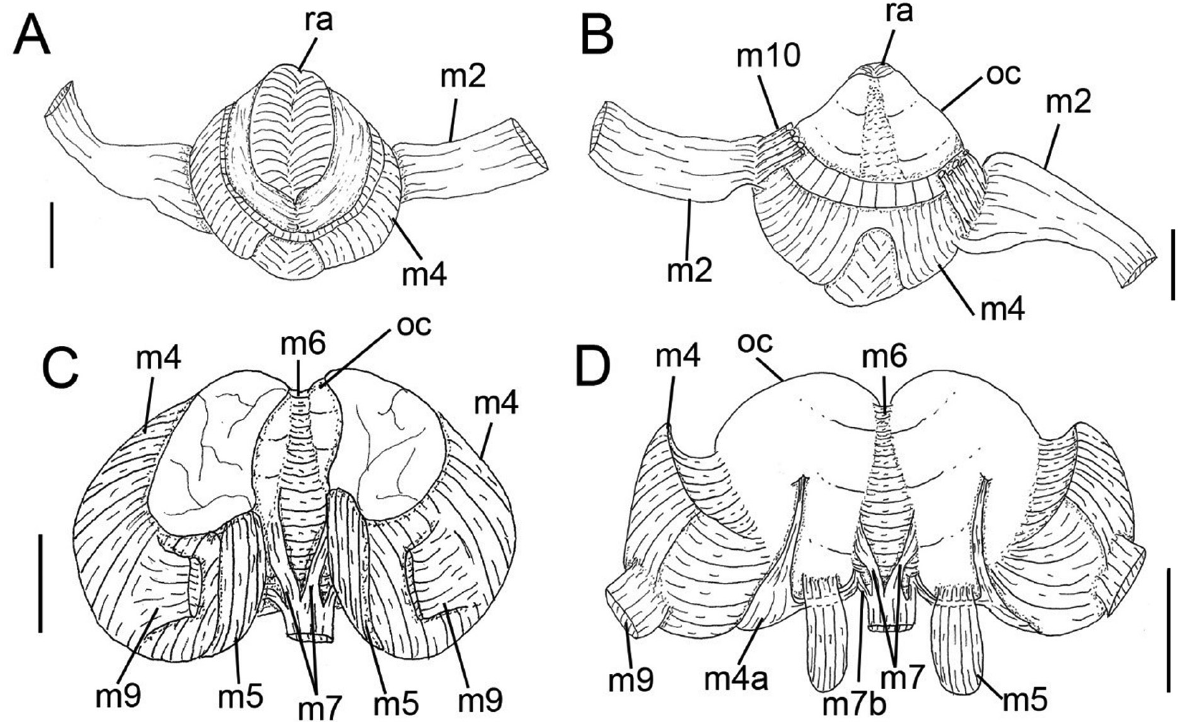
Figure 9. Platydoris guarani . Odontophore. A dorsal view with radula B same, ventral view C same, dorsal view with removed radula D same, dorsal view, with folded down muscles. Scale bars: 2 mm.